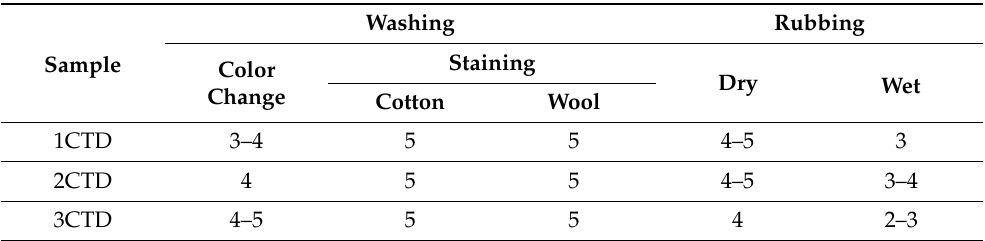
Table 12. Results of the washing and rubbing fastness tests of samples with pre-mordanting, post- mordanting, and mordanting during dyeing with